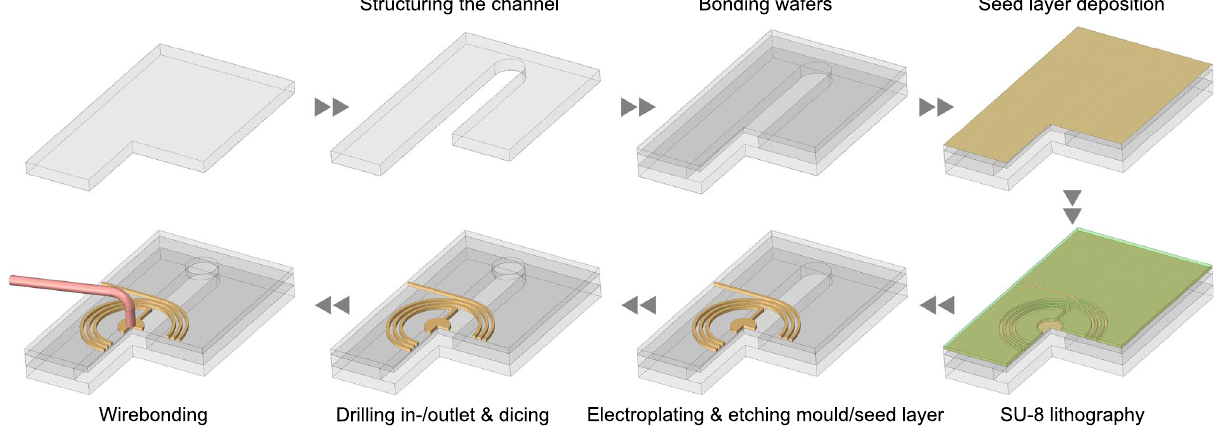
Figure 5. Fabrication process started with structuring the channel in the middle wafer. The process was continued with bonding three wafers together with SU-8 (not shown here) and coating the top side of the assembly with the seed layer. Using UV-lithography, a mould was patterned on the top side and the metallic structures were deposited. After removing the mold and the seed layer, the inlet and outlets were drilled with laser and the assembly was diced into individual chips. The process was concluded by connecting the centre pad of the coil to its corresponding